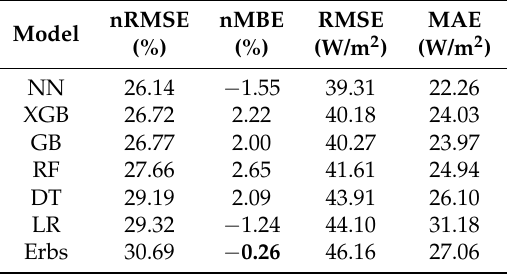
Table 7. The performance metrics of different models on Mannheim climate for diffuse horizontal irradiance on 2017 data.